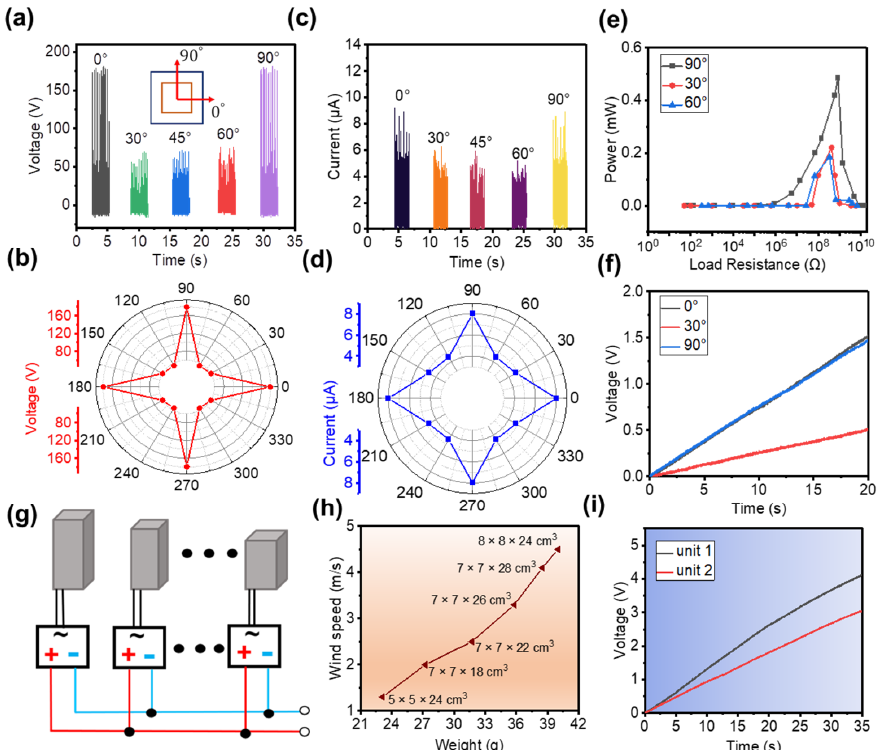
Figure 4. ( a , b ) V OC of the CS-TENG at different wind angles. ( c , d ) I SC of the CS-TENG at different wind angles. ( e ) Output power of the CS-TENG at different wind angles. ( f ) Charging a 22 µ F capacitor at different wind angles. ( g ) Diagram of the parallel circuit with different CS-TENGs. ( h ) Turn-on wind speeds for CS-TENGs of different weight. ( i ) Charging performance of CS-TENGs with different numbers of integrated units.